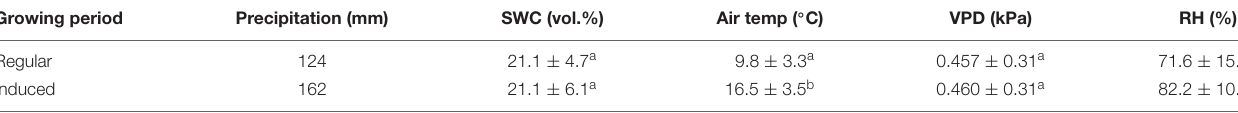
TABLE 2 | Climate variables and soil water content during the regular (i.e., pre-girdling) and induced (i.e., post-girdling) growing period (cf. Figure 2 ). Growing period